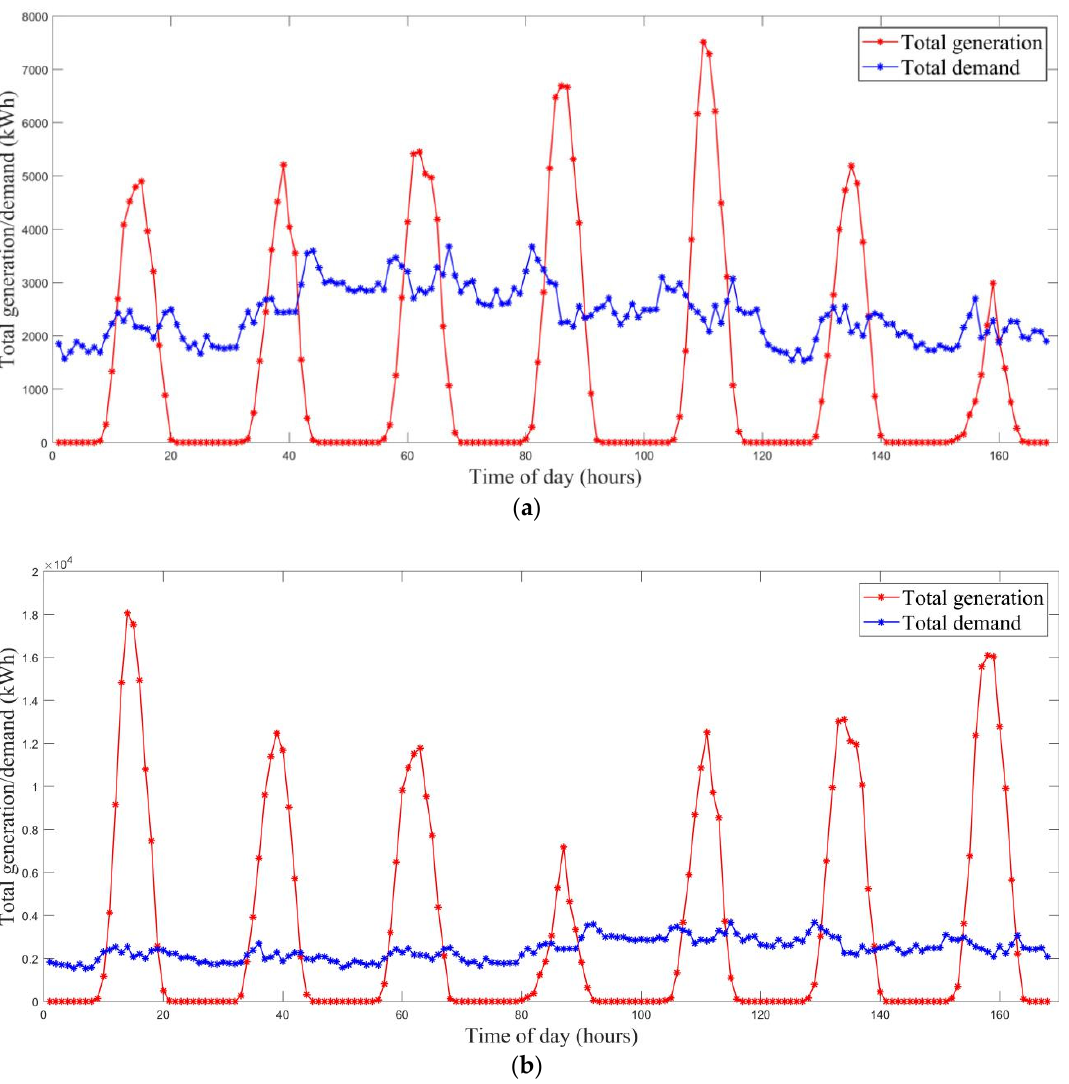
Figure 4. The total generation and consumption data of the 7 × 24-h period: ( a ) with low irradiation and ( b ) with high irradiation.